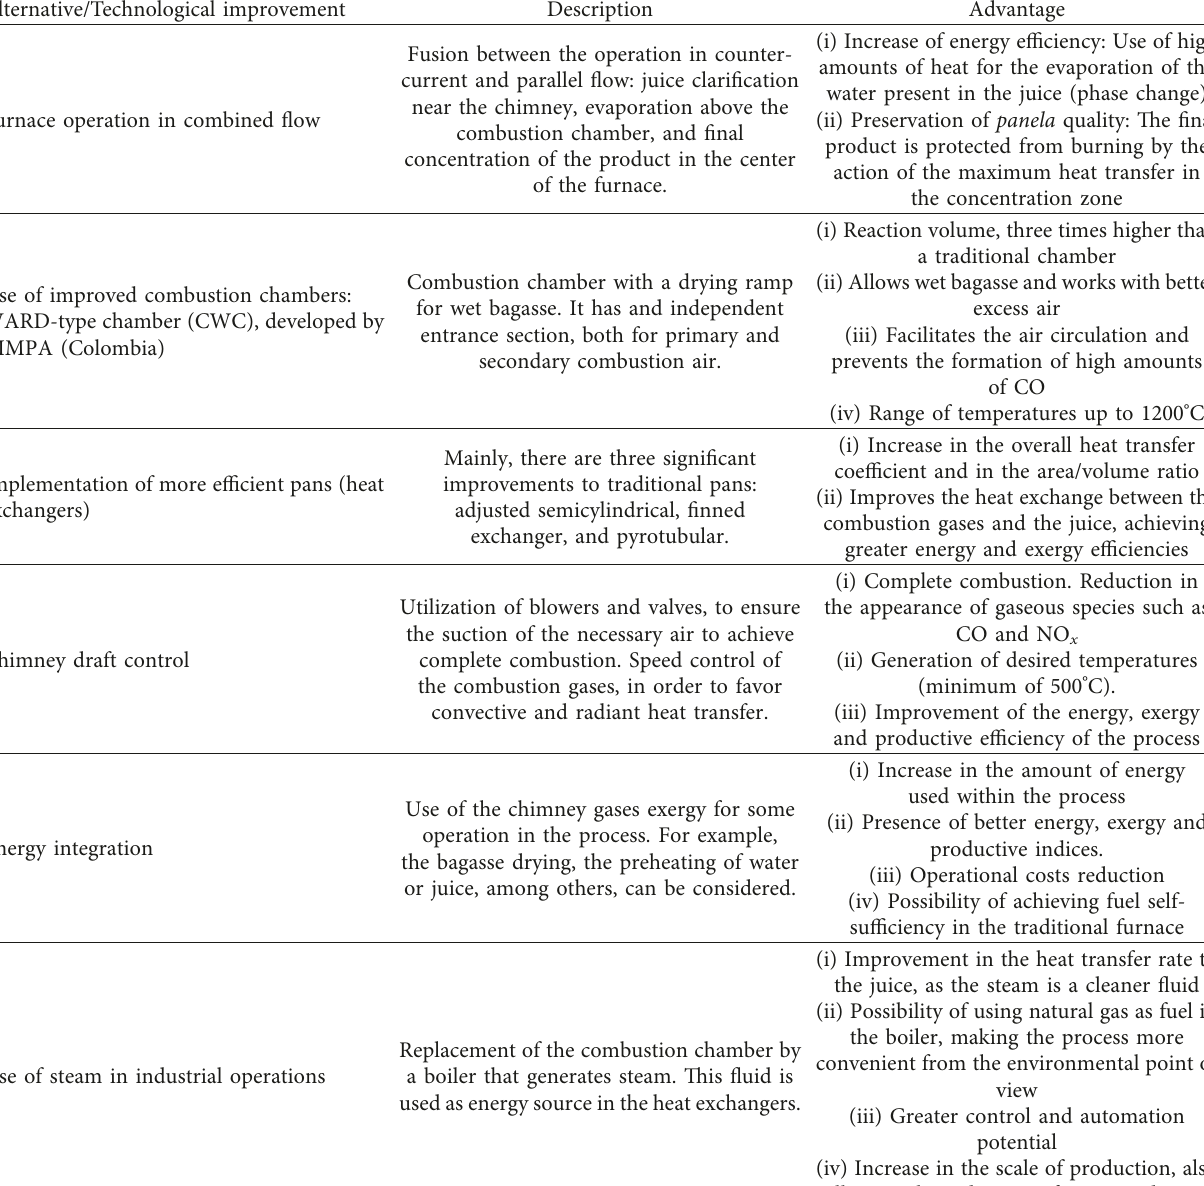
Table 5: Technological alternatives for improving performance of traditional